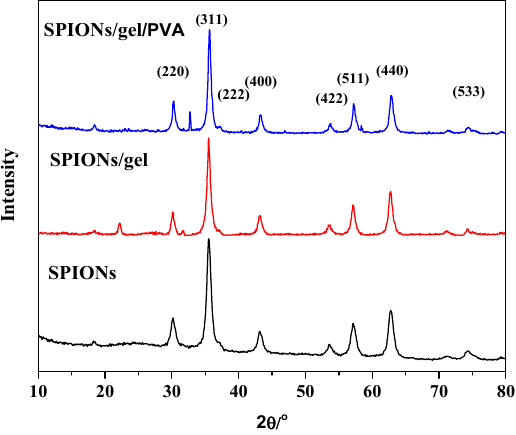
Figure 3. XRD spectra of SPIONs, SPIONs/gel and SPIONs/gel/PVA.